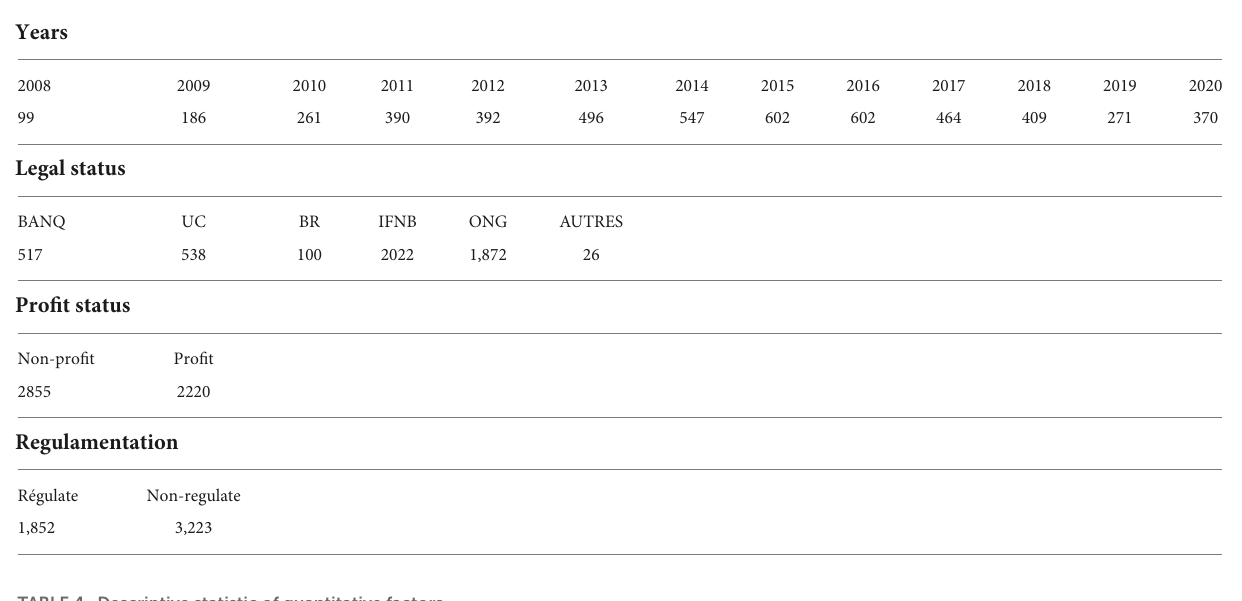
TABLE 3 Frequency of categorical variables.